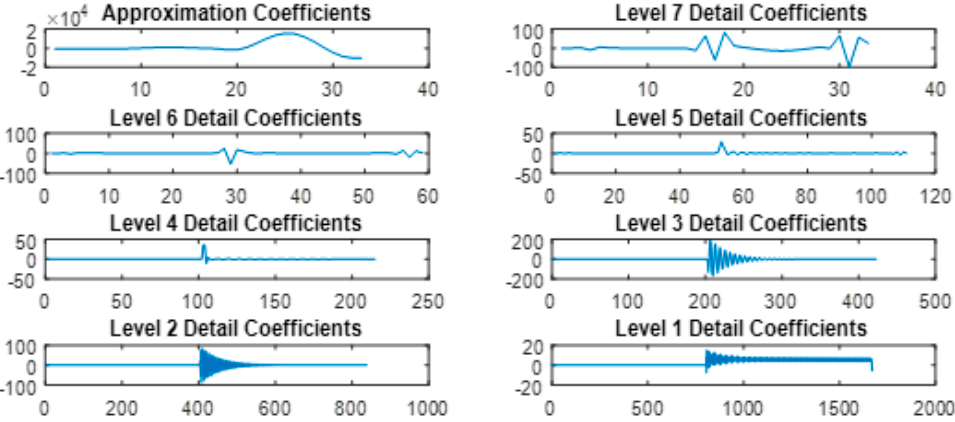
Figure 6. Useful features’ extraction from three-phase current signals and DWT: Approximate and detailed coefficients of phase A for a SLG fault applied on phase.